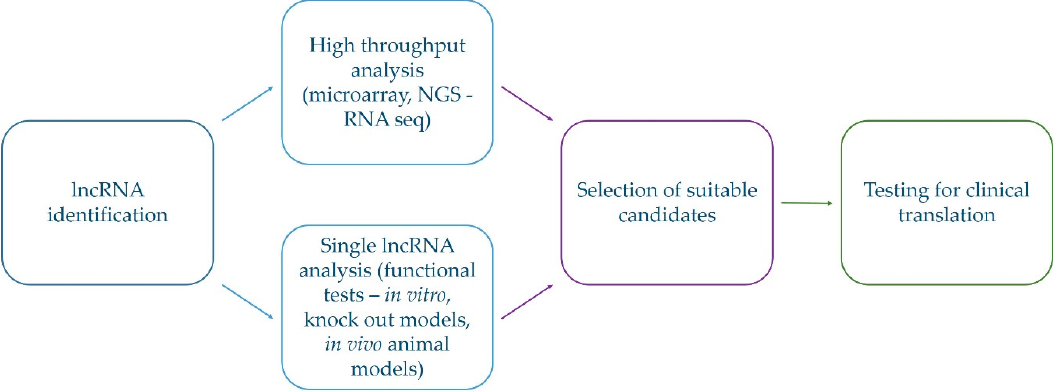
Figure 4. Schematic representation of selection of suitable lncRNA candidates for translation into clinical practice. Selection of promising lncRNAs starts from identification of lncRNAs with differential expression in glioblastoma which is followed by confirmatory tests and examination of the functioning roles. Only after this is completed, their utilization in clinical practice can be considered.